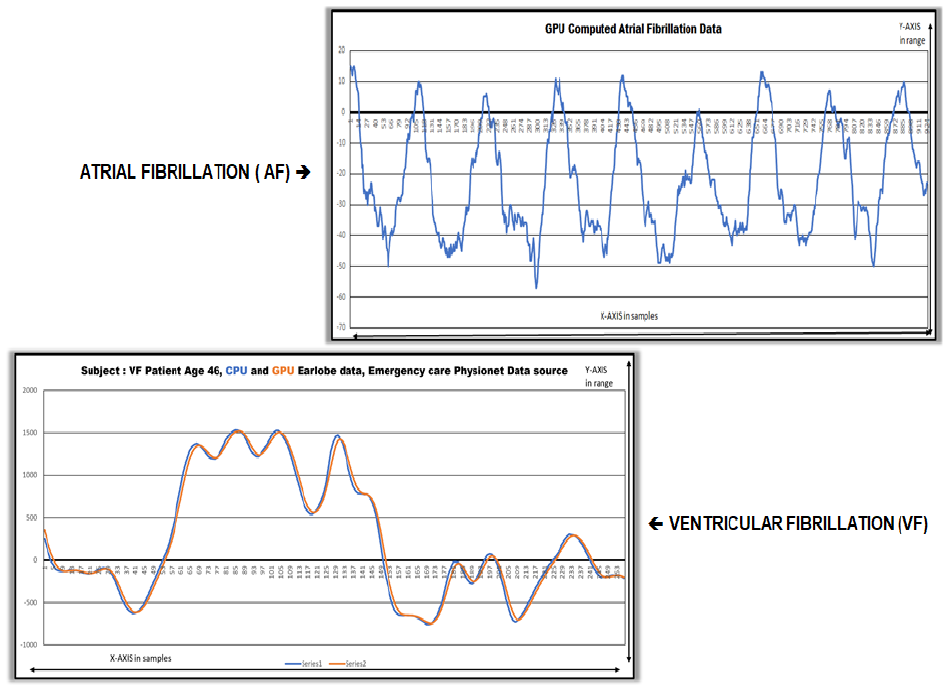
Figure 21. Atrial and Ventricular Data in real-time.